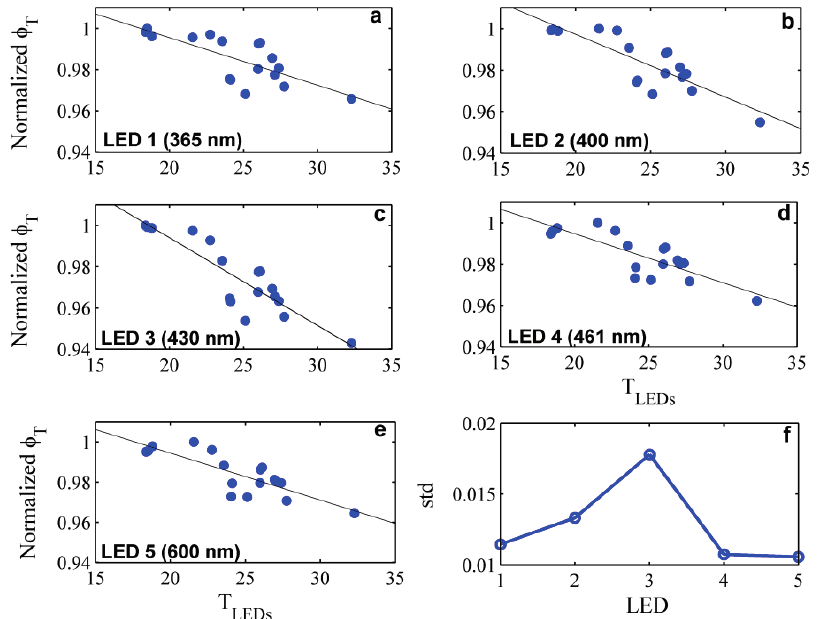
Figure 5. ( a – e ) Normalized transmitted light intensity as function of the operating temperature at the emission peak wavelengths of the five LEDs ( i.e ., 365 nm, 400 nm, 430 nm, 461 nm and 600 nm, respectively). The linear regression slope indicates the rate of change in the corrected output signal with the temperature of the diode; ( f ) Standard deviation of the measured data for the five LEDs.